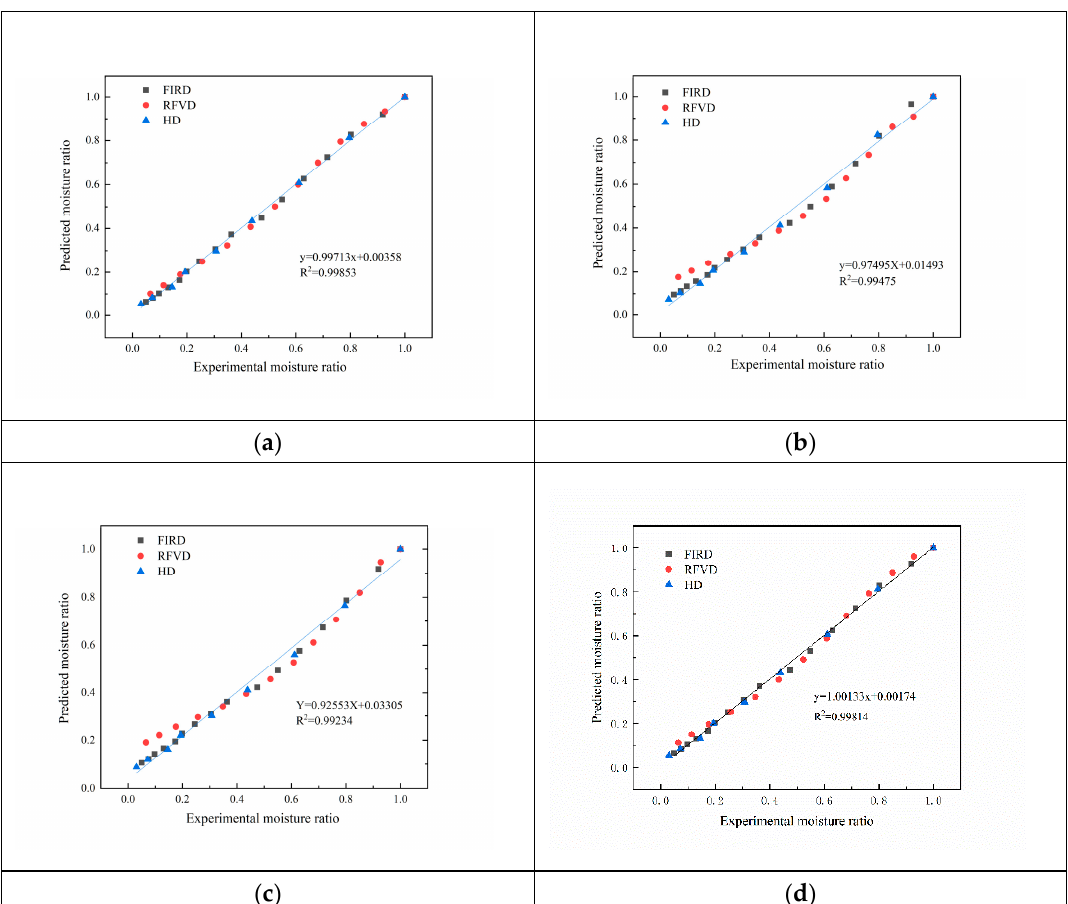
Figure 2. Experimental determined and predicted moisture ratio by Overhults ( a ), Verma ( b ), Dincer ( c ), and Weibull ( d ) model with different drying methods. Table 3. Model fitting results.